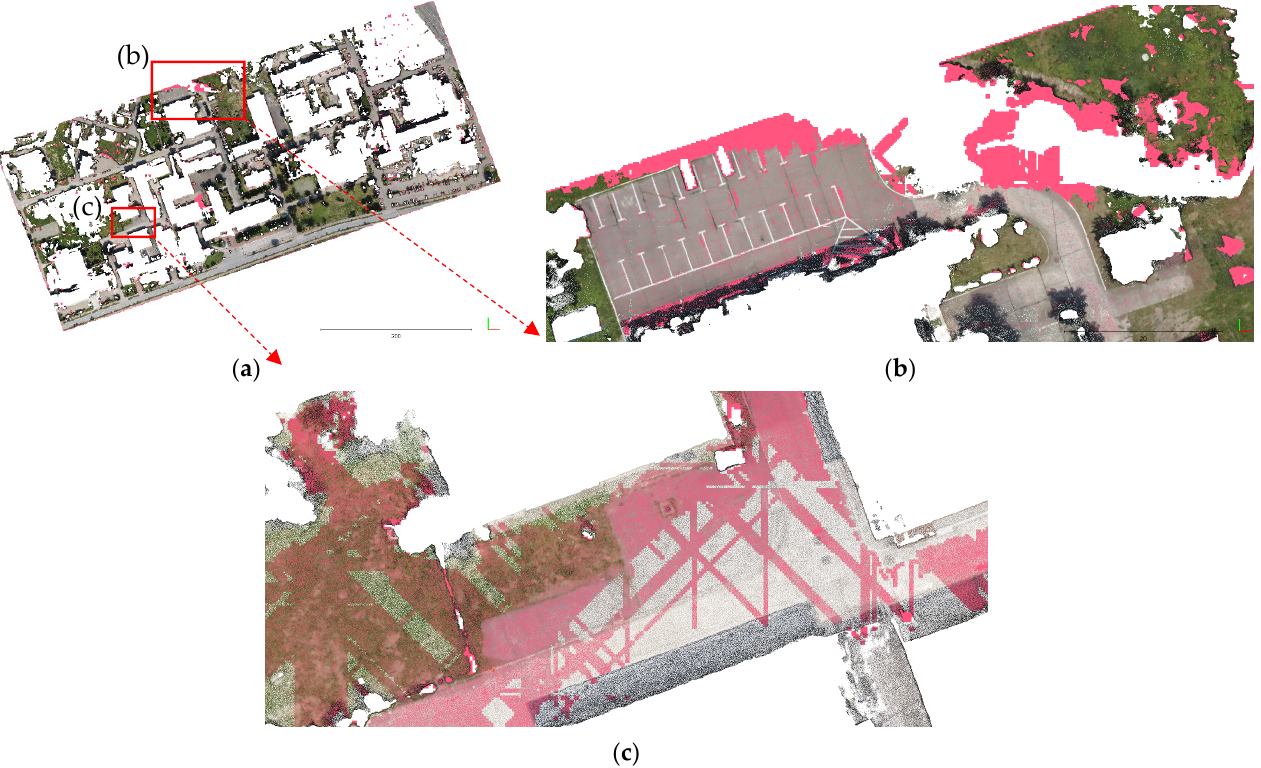
Figure 9. ( a ) Terrain mask overlaid over ground points classified with the CSF algorithm, ( b ) detail with open terrain parts correctly identified by terrain mask algorithm and unidentified by the CSF algorithm and ( c ) detail with open terrain parts correctly identified by the CSF algorithm and unidentified by terrain mask algorithm.